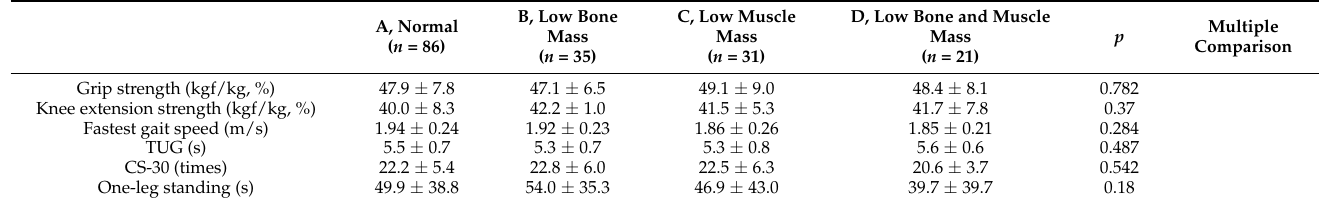
Table 2. Comparison of physical functions of elderly participants in early elderly stage among the four groups.